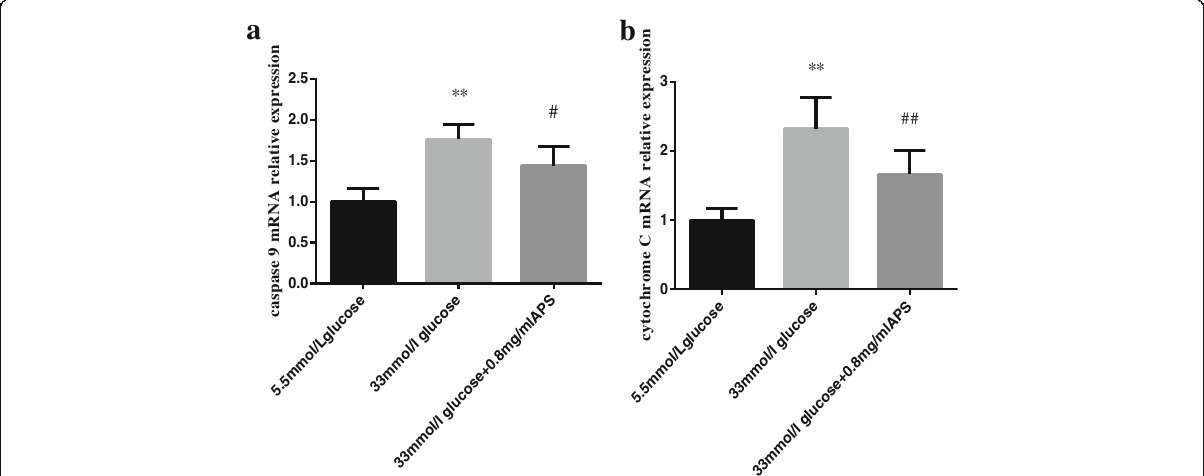
Fig. 5 APS modulated the mRNA expression levels of intrinsic apoptotic pathway-related factors. H9C2 cells were pre-incubated with/without APS for 24 h and then treated with 33 mmol/L glucose for 24 h. The expression of GAPDH was measured as an internal control. a . the relative mRNA expression levels of caspase 9 in different groups. b . the relative mRNA expression levels of cytochrome C in different groups. Data were